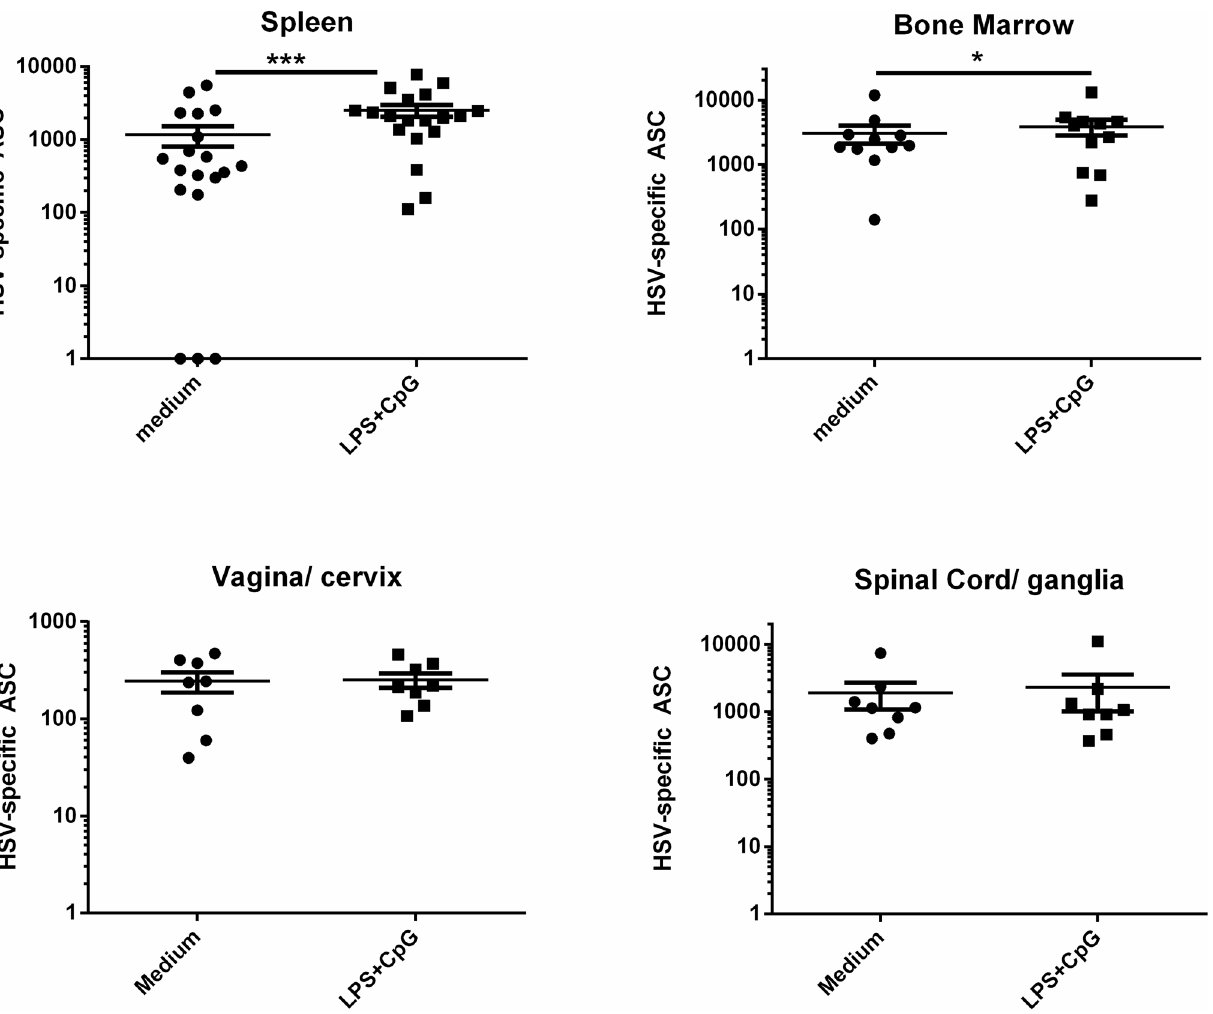
Fig. 1. HSV-specific ASC residing long-term in the female genital tract, lumbosacral ganglia and adjacent spinal cord are predominantly plasma cells. Hartley guinea pigs were infected ivag with HSV-2 strain MS. Lymphocytes from the spleen, bone marrow, vagina/cervix, and lumbosacral ganglia and adjacent spinal cord of individual animals were harvested between days 49–70 after infection and stimulated with medium or LPS/CpG and HSV-specific ASC quantified by ELISPOT. Each data point represents results from an individual animal. Results shown include tissues from three experiments for spleen and bone marrow and two experiments for vagina/cervix and spinal cord/ganglia. HSV-specific ASCs from tissues of uninfected animals were always less than five ASC/tissue. (* P , 0.05; *** P , 0.0001, Student’s t